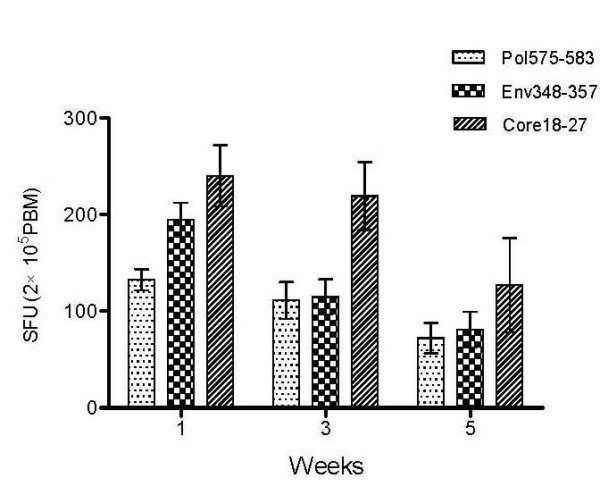
Dynamic changes of HBV antigen specific CTL responses in AHB patients. CTL responses against three HBV epitopes (Pol575-583, Env348-357 and Core18-27) were measured by ELISPOT at different time points after admission to hospital.